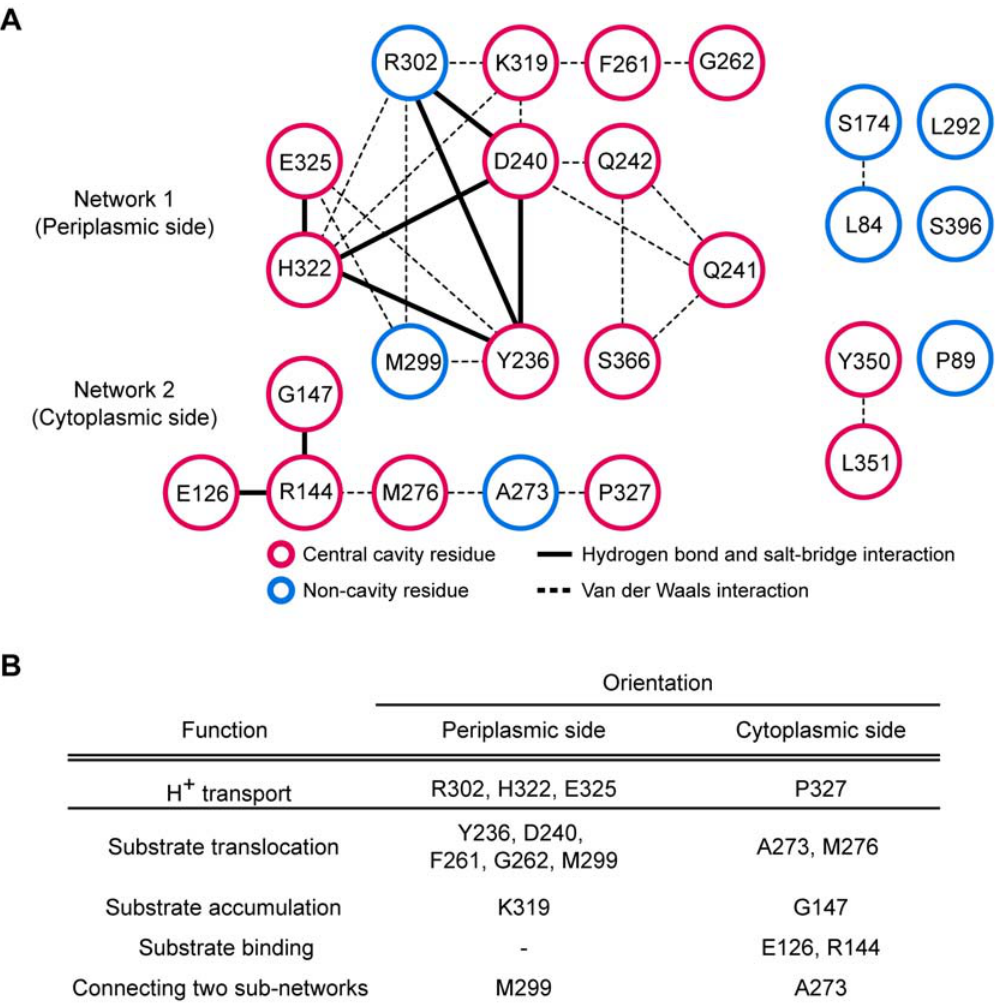
Figure 4. Interaction network of the high-IS residues of LacY. (A) Interaction network of the detected residues in LacY. Eighteen of the detected residues comprised a main interaction network (left), which can be divided into two sub-networks. Red circle represents central cavity residues and blue circle indicates non-cavity residues. Dashed line indicates a van der Waals interaction. Bold line indicates a potential hydrogen bond or salt bridge. (B) Functional implications of the detected residues from the mutational